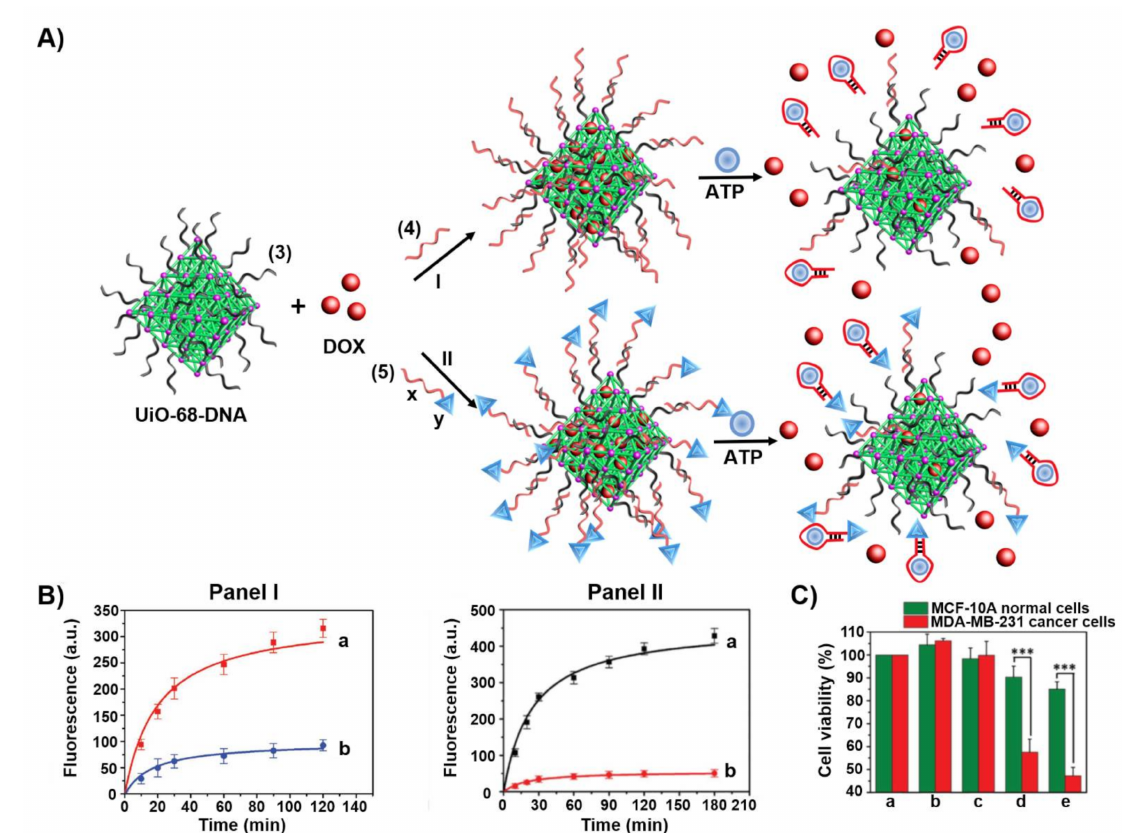
Figure 7. ( A ) Synthesis of doxorubicin (DOX)-loaded ATP aptamer-gated UiO-68 NMOFs and the ATP-driven release of the drug from the NMOFs through the formation of ATP/ATP aptamer complexes; (I) locking of the NMOFs with the ATP aptamer ( 4 ) (II) locking of the NMOFs by the ATP aptamer conjugated to the AS1411 aptamer as cancer cell targeting unit ( 5 ). ( B ) Time-dependent release of DOX from: Panel I—ATP aptamer-gated NMOFs: a. in the presence of ATP, 25 nM; b. in the absence of ATP. Panel II—ATP/AS1411 aptamer-gated NMOFs: a. in the presence of ATP, 25 mM; b. in the absence of ATP. ( C ) Cytotoxicity of the DOX-loaded ATP-responsive NMOFs towards normal MCF-10A epithelial breast cells (green) and MDA-MB-231 breast cancer cells (red) and appropriate control experiments: a. = untreated cells; b.= unloaded ATP aptamer-modified NMOFs; c = unloaded ATP/AS1411 aptamer-modified NMOFs; d = ATP aptamer-modified NMOFs loaded with DOX; e = ATP/AS1411 aptamer-modified NMOFs loaded with DOX (cells treated for a time-interval of three days). Data are averages ± SD ( n = 3 experimental replicates). *** p < 0.001 by t-test versus normal cells. Reproduced with permission from ref. [155]. Copyright 2017